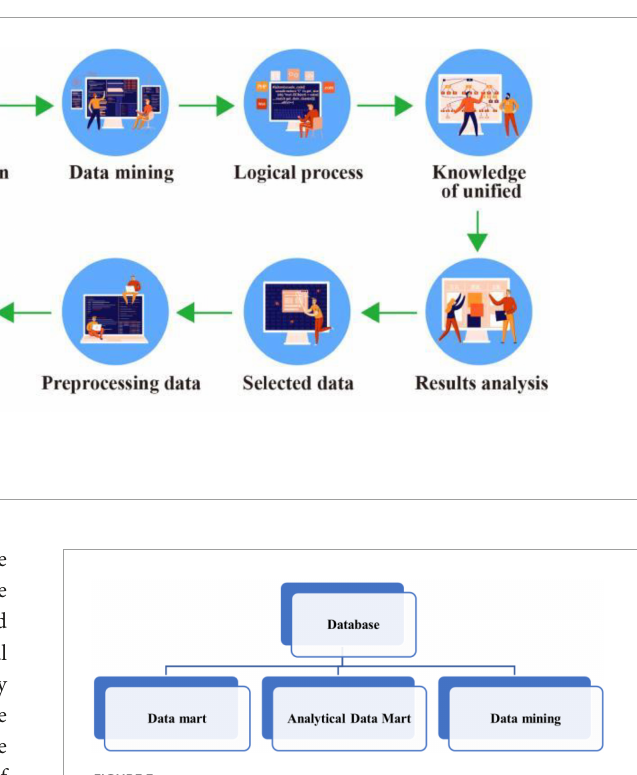
FIGURE3 Data mining library obtained from data